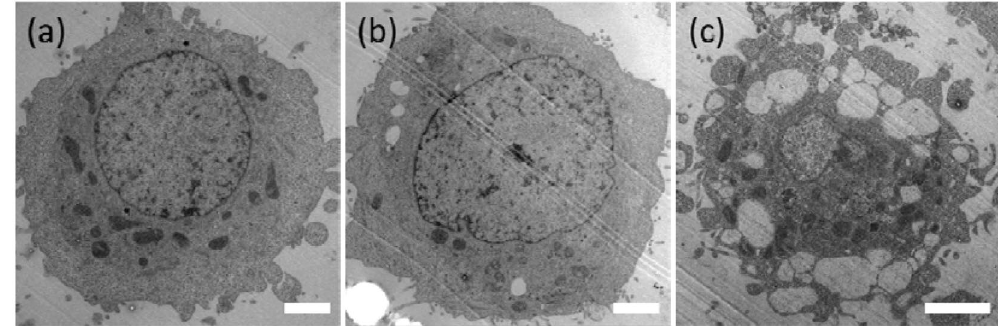
Figure 4. The effects of PLGA-PEG NPs’ shape on cell morphology. TEM images of the morphologies of HepG2 cells after their being fed with ( a ) none (control sample), ( b ) spherical-, and ( c ) needle-shaped NPs at 250 µ g/mL for 24 hours. (Scale bar: 2 µ